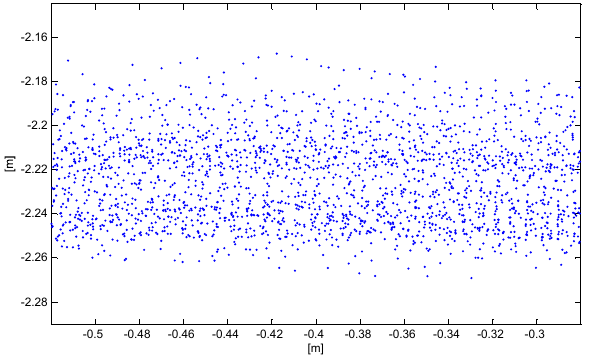
Figure 1: Top view of a point cloud representing a wall